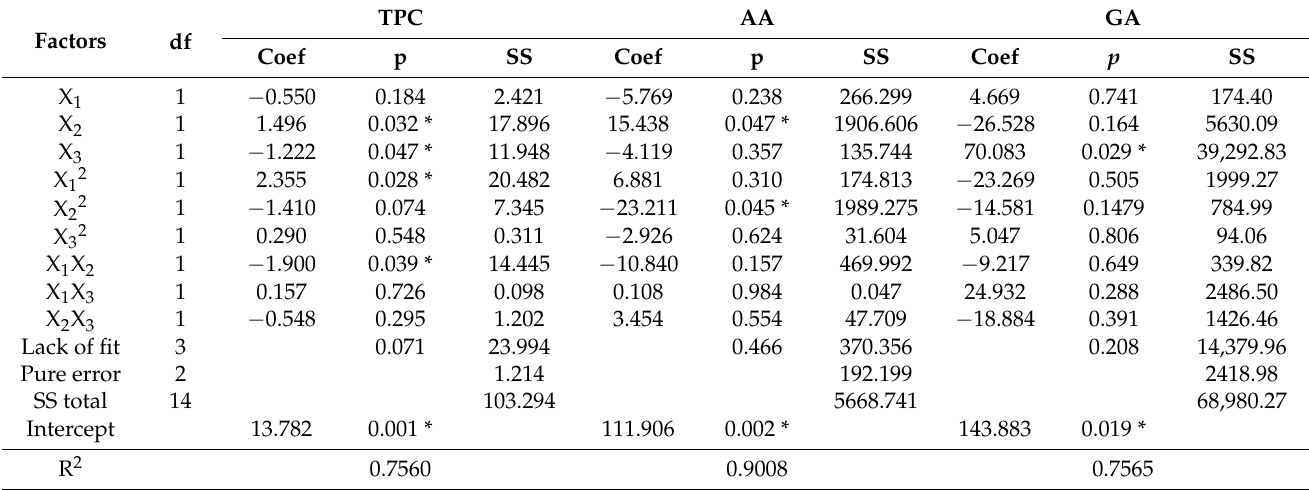
Table 2. Analysis of the variance and polynomial regression